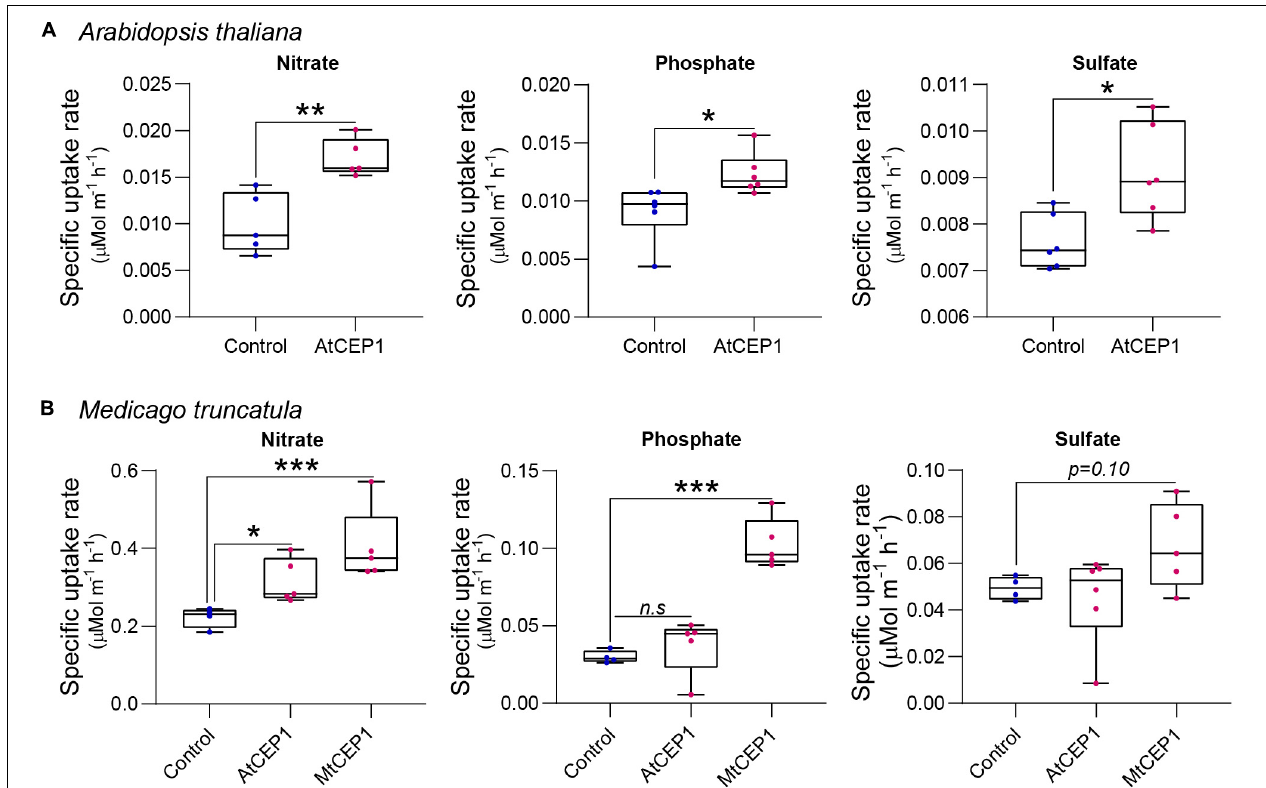
FIGURE 3 | Synthetic CEP1 peptides enhance uptake of nitrate, phosphate, and sulfate in Arabidopsis thaliana and Medicago truncatula . (A) Specific nutrient uptake rates of nitrate, phosphate, and sulfate in A. thaliana in the presence or absence of the synthetic AtCEP1 peptide at a concentration of 1 µ M. (B) Uptake rate of nitrate, phosphate, and sulfate in Medicago truncatula in the presence of synthetic AtCEP1 and MtCEP1 peptide domain 1 at a concentration of 1 µ M. Student’s t -test * p < 0.05, ** p < 0.01, *** p < 0.001. n = 5–6 per